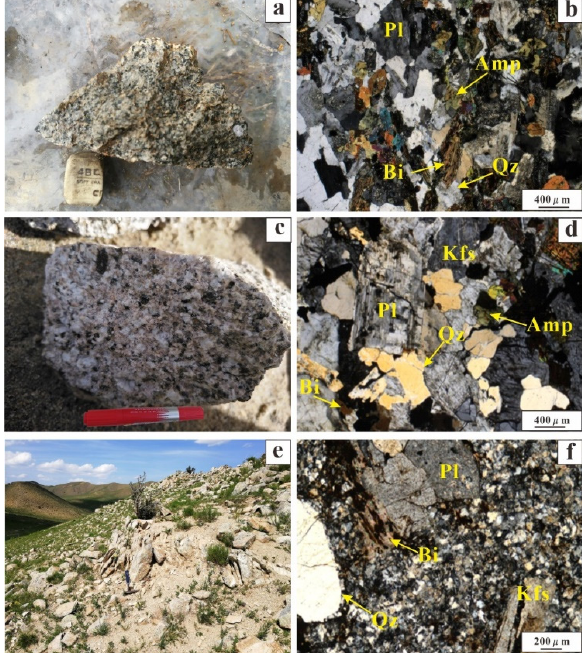
Figure 3. Photographs (left) and corresponding thin section photomicrographs (right) of the granitoids from Zalute. ( a , b ) Quartz diorite, ( c , d ) monzogranite, and ( e , f ) granite porphyry. Mineral